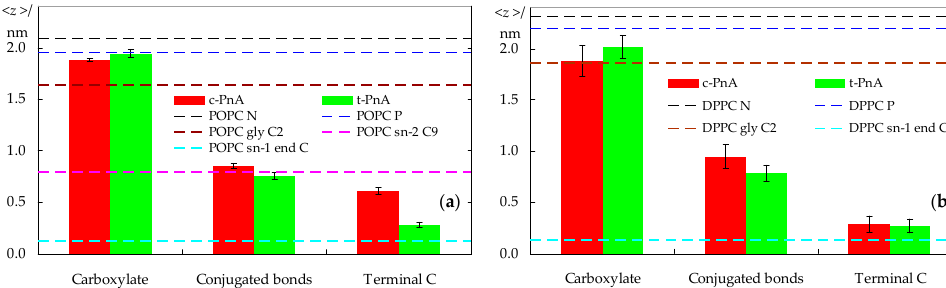
Figure 4. Average transverse distances to the bilayer center of mass for three probe groups (in columns) and, as reference, for different lipid atoms in probe-free systems, calculated for the POPC ( a ) and DPPC ( b ) simulations. Error bars reflect standard errors for the 95% confidence level.